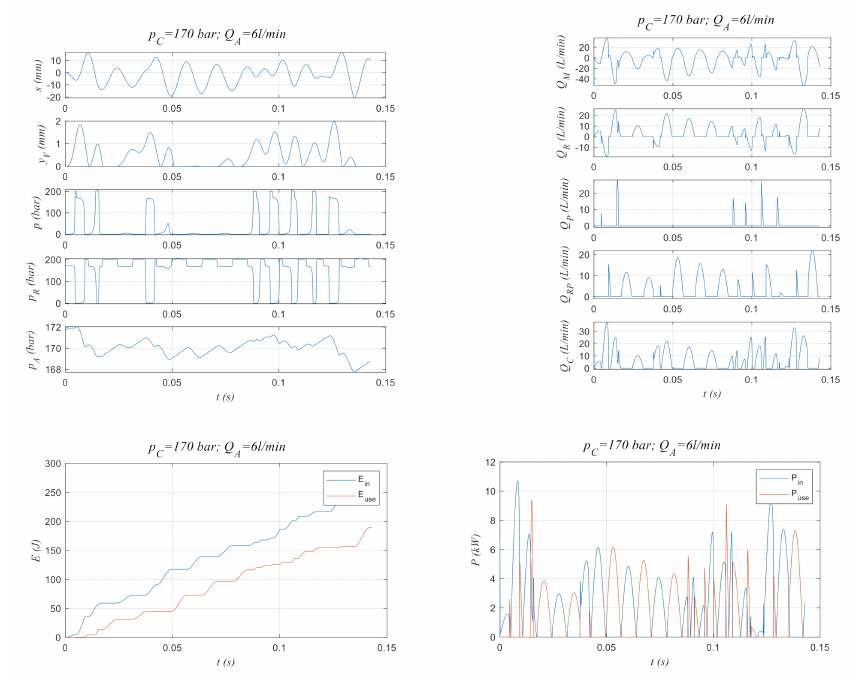
Figure 8. Results plots for p C = 170 bar, Q A = 6 L/min; s: piston position; y V : position valve spool; p, p R , p A : pressures in cylinder chambers and in entry side capacitance; Q M , Q R , Q P , Q RP , Q C : flow rates over switching valve to piston and rod side chambers, over check valves to system pressure, and to actuator CA; E in , E use , P in , P use : input and recuperated energy and power,